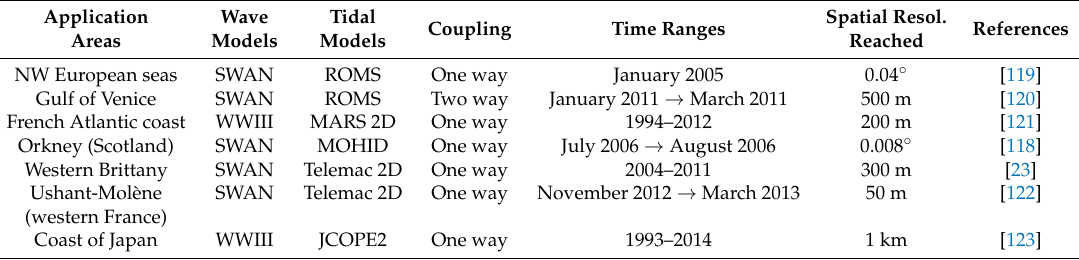
Table 9. Review of coastal numerical wave energy resource assessments which integrated the effects of tidal currents.